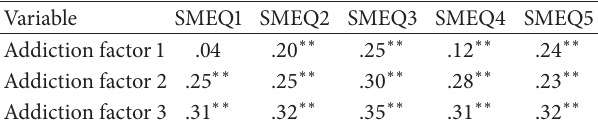
Table 4: Concurrent validity by correlating social media addiction factors with Social Media Engagement Questionnaire (SMEQ)